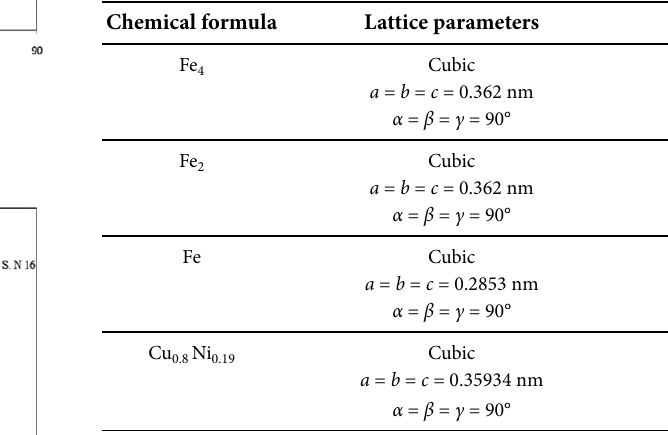
Table 7. Lattice parameters of workpiece surface phases, work- piece-16.